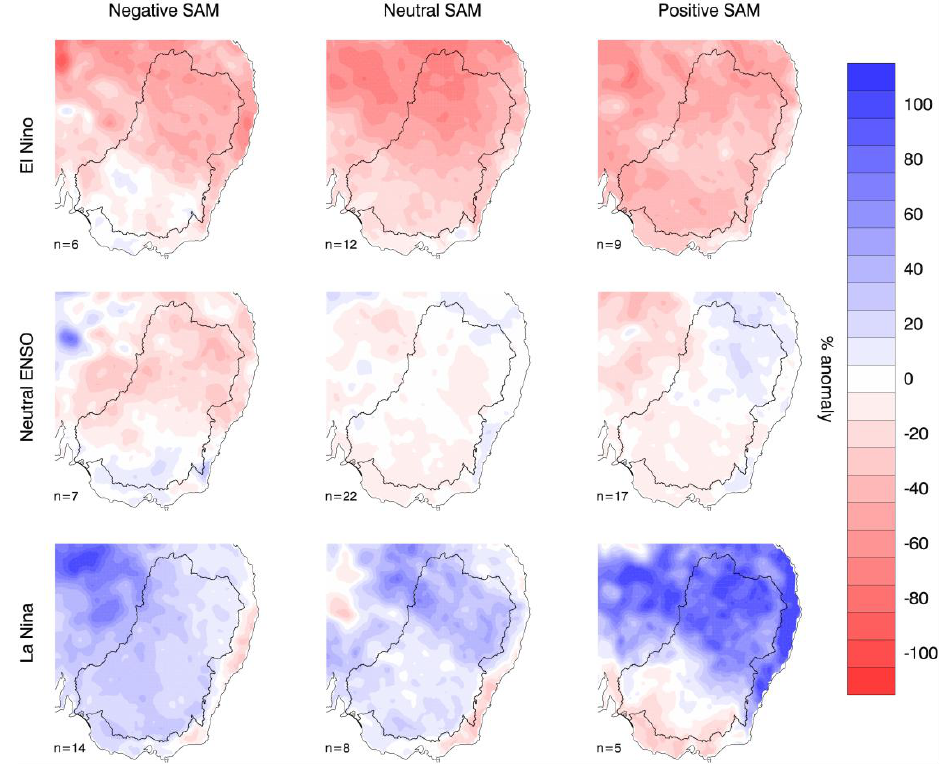
Fig. 7. Composite mean percentage winter (June–August) rainfall anomalies in the MDB during co-occurring phases of the SAM and ENSO from 1905–2004. A positive or negative phase of SAM and ENSO was defined when the standardised anomalies (relative to 1905–2004) of each index exceeded ± 0.5 standard deviations. Red colours indicate rainfall deficits and blue, rainfall surplus. The number, n , in each panel indicates the number of years from which the composite was computed, this is, the number of years in which the particular phases of ENSO and SAM co-occurred. Rainfall data is from the AWAP high-quality Australian rainfall grids (Jones et al.,